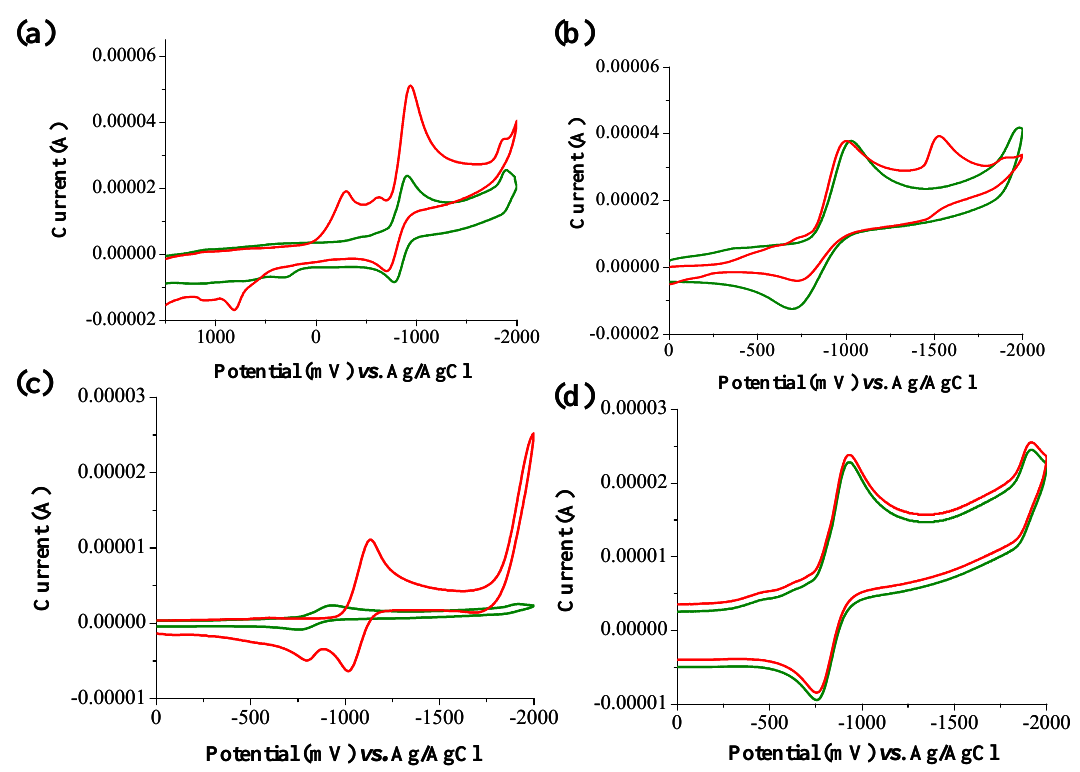
Figure 15. Cyclic voltammograms of DQA before and after addition of (a) ethion, (b) malathion, (c) parathion, and (d)